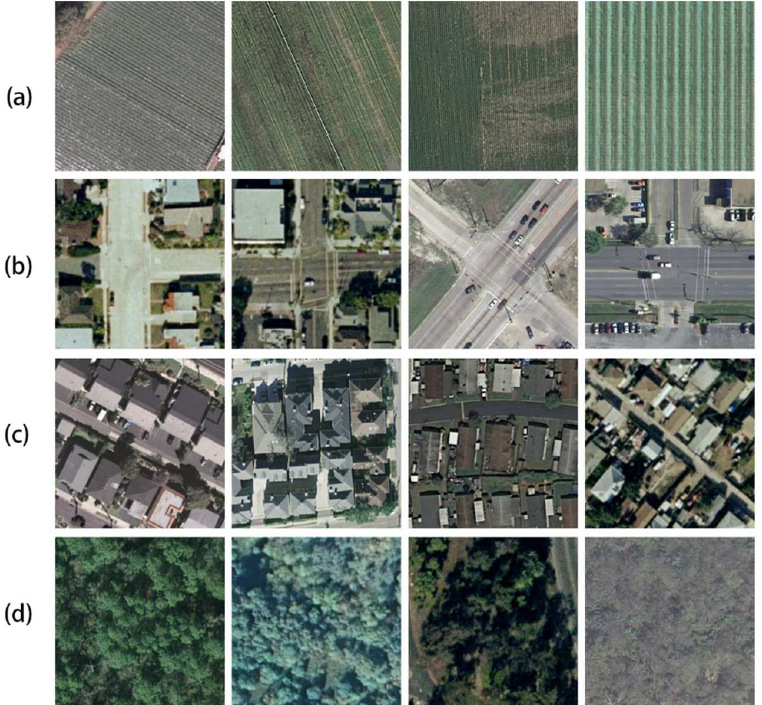
Figure 5. Sample images of each scene in UC-Merced dataset (( a ): cultivated land; ( b ): Road intersection; ( c ): residential land; ( d ): forest land).